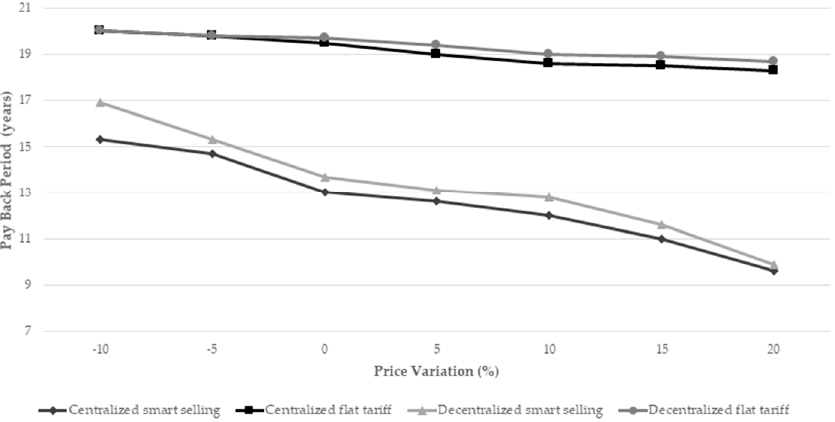
Figure 2. Simple payback period under assumptions of the intelligent and flat energy selling price.